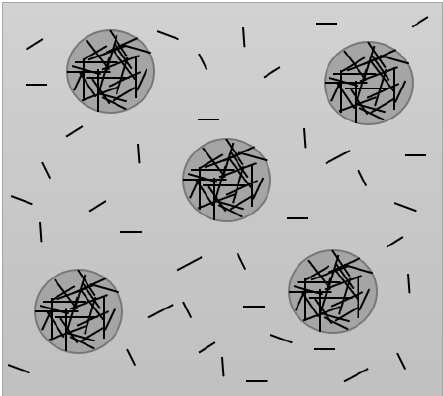
Figure 1. Eshelby inclusion model of randomly oriented carbon nanotubes.